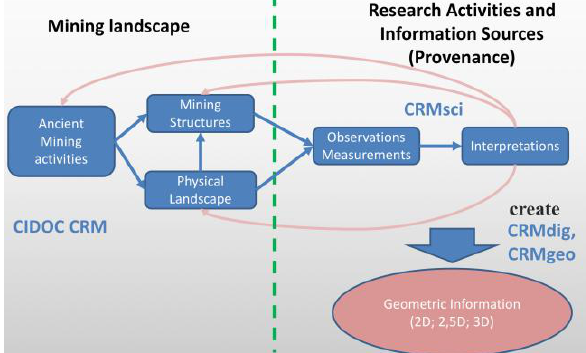
Figure 7. Relation of Mining Landscape, Information Sources